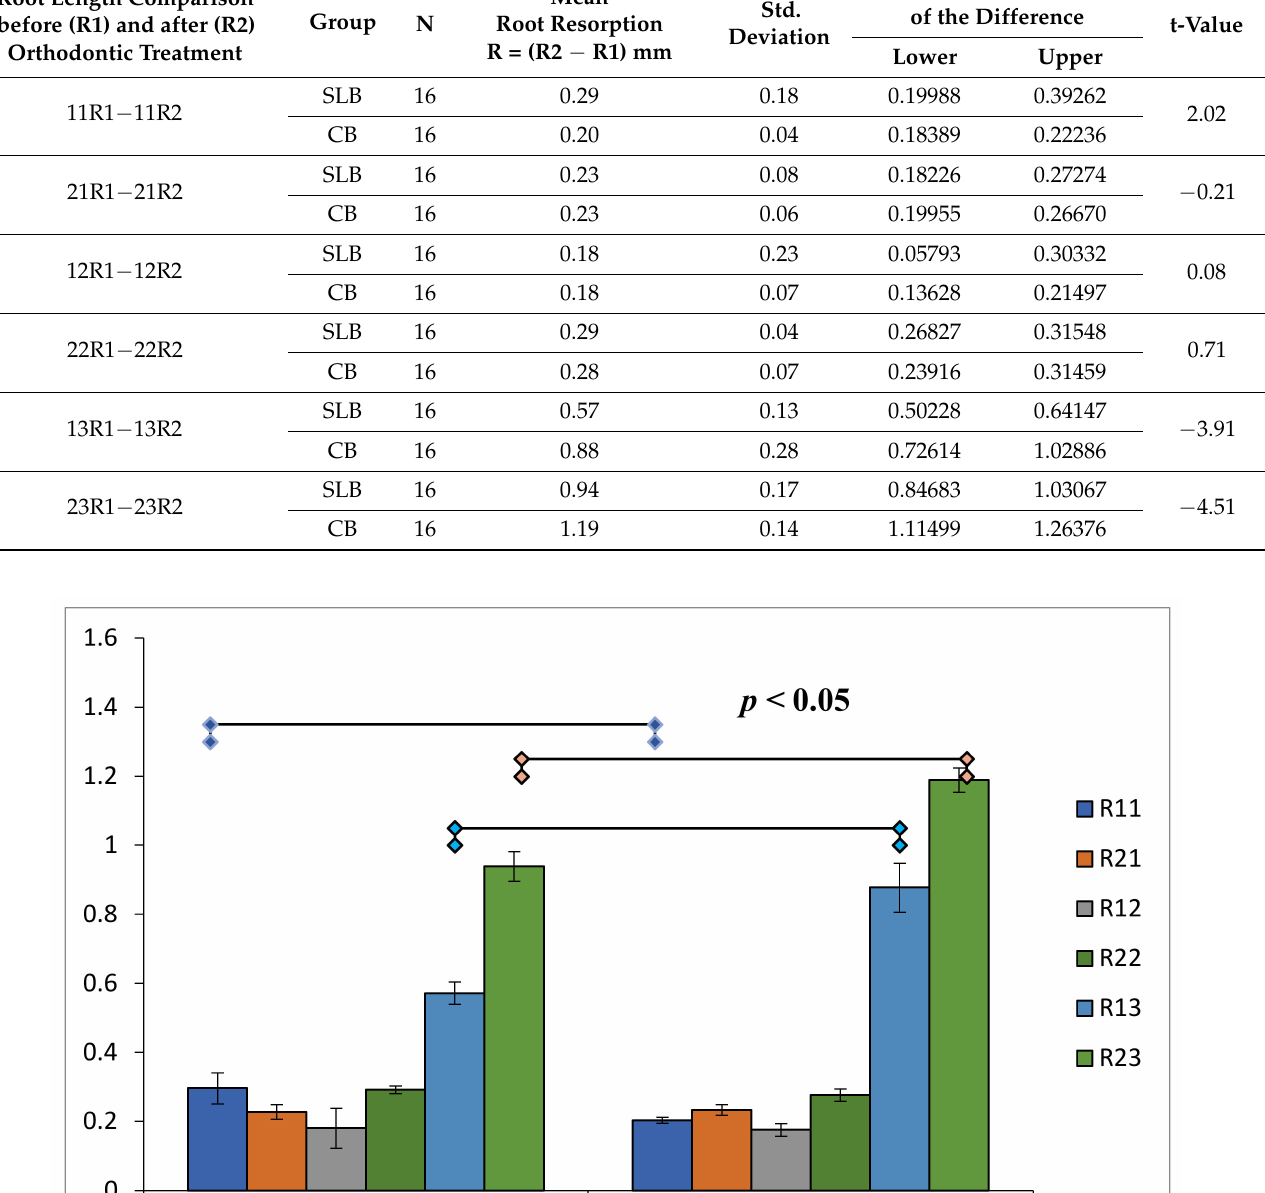
Table 1. Mean comparison of root resorption after orthodontic therapy in SLB and CB group. Root Length Comparison